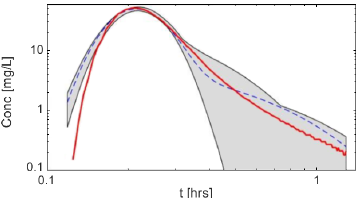
Figure B2. Observed BTC (red line) together with the grey area comprised between the top 100 simulated BTCs and the best-fitting BTC (blue dashed line) for the second TSM iteration